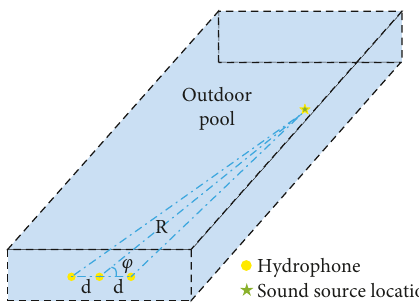
Figure 16: Schematic diagram of the experimental site.